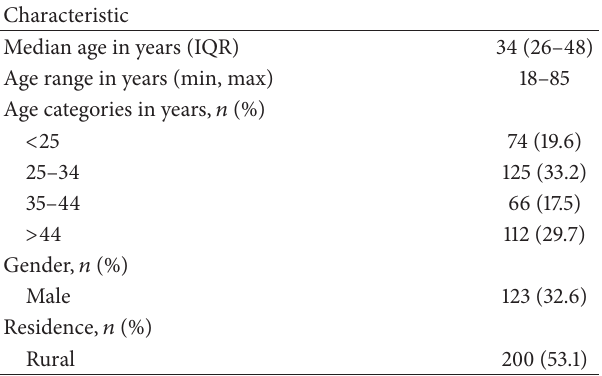
Table 2: Knowledge of Parkinson’s disease ( 𝑁 = 377